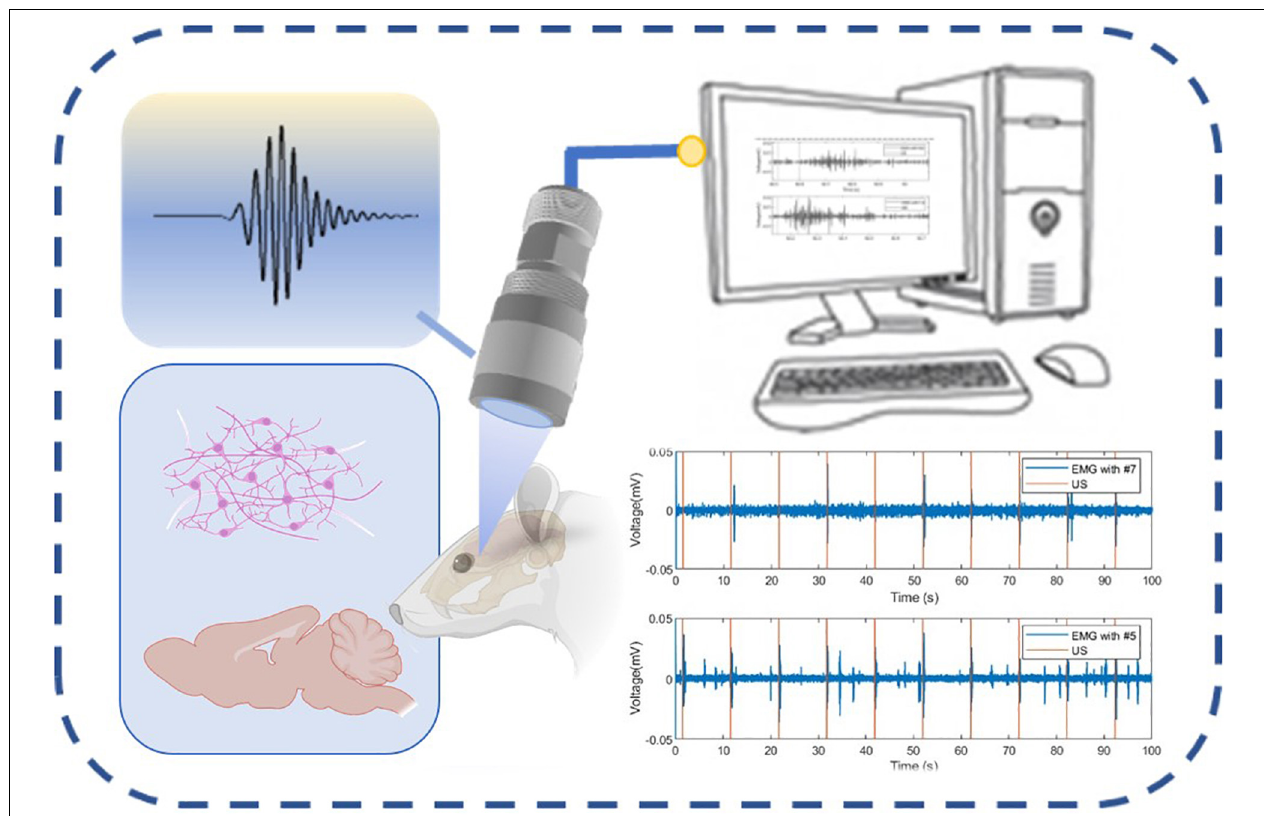
FIGURE 1 | Schematic diagram of the neural regulation process.